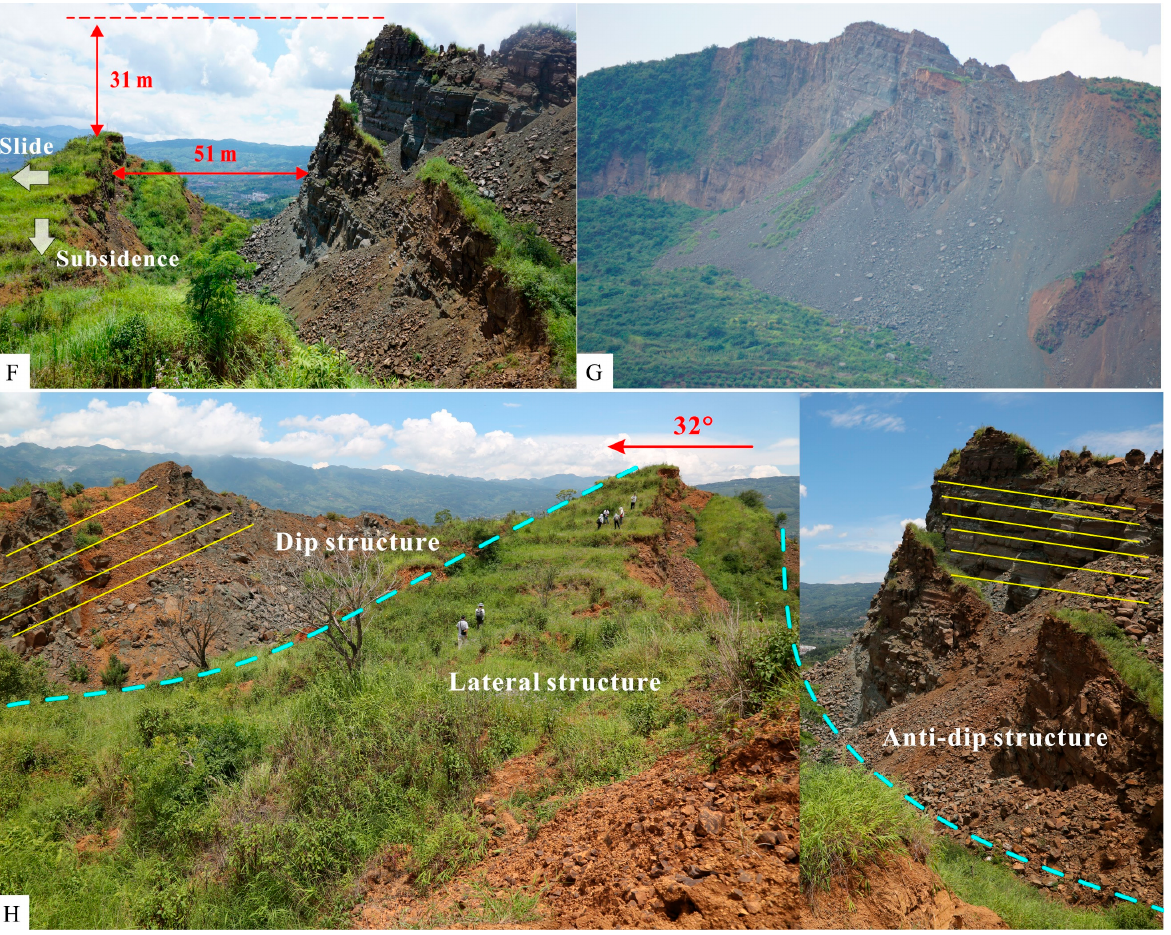
Figure 13. Deformation characteristics of zone II: ( F ) large-scale tensile cracking trough on the SE side; ( G ) fractured rock mass on the SE side; and ( H ) change in the stratigraphic structure. The specific locations of features F–H are shown in Figure 8.